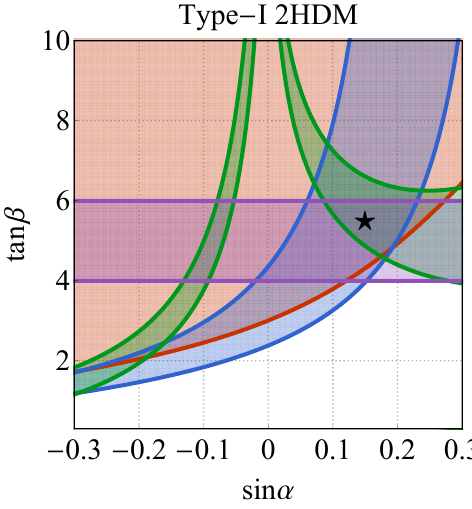
Figure 6 . As (cid:12)gure 2 but for the star ( ? ) benchmark scenario (3.2). The range of tan (cid:12) favoured by the leptonic excess in t (cid:22) th production [11] is indicated in purple. See text for further details. not rule out the choice of tan (cid:12) made in (3.1). Improved LHC searches for B s ! (cid:22) + (cid:22)